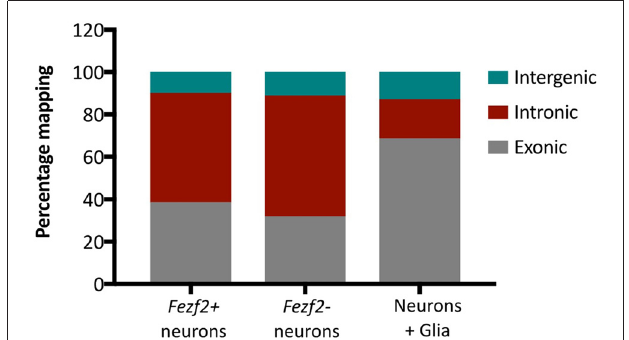
TABLE 1 | Mapping rate of RNA-sequencing reads from Fezf2+ve and Fezf2 − ve IT-PN samples (number indicates sample pair). Number of processed reads